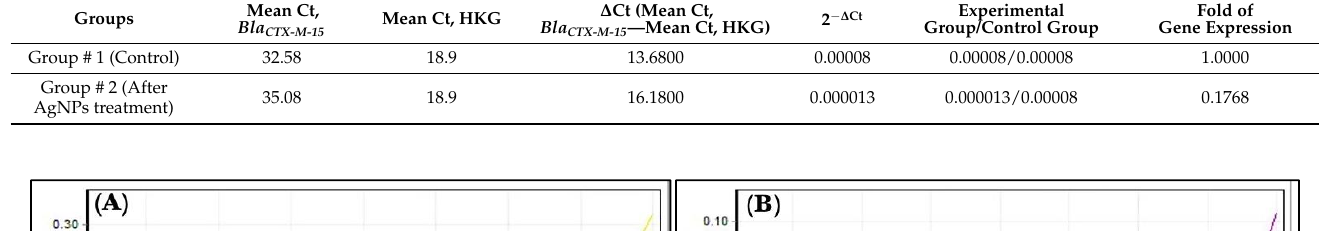
Table 7. Comparison of Bla gene’s fold expressions between the groups.